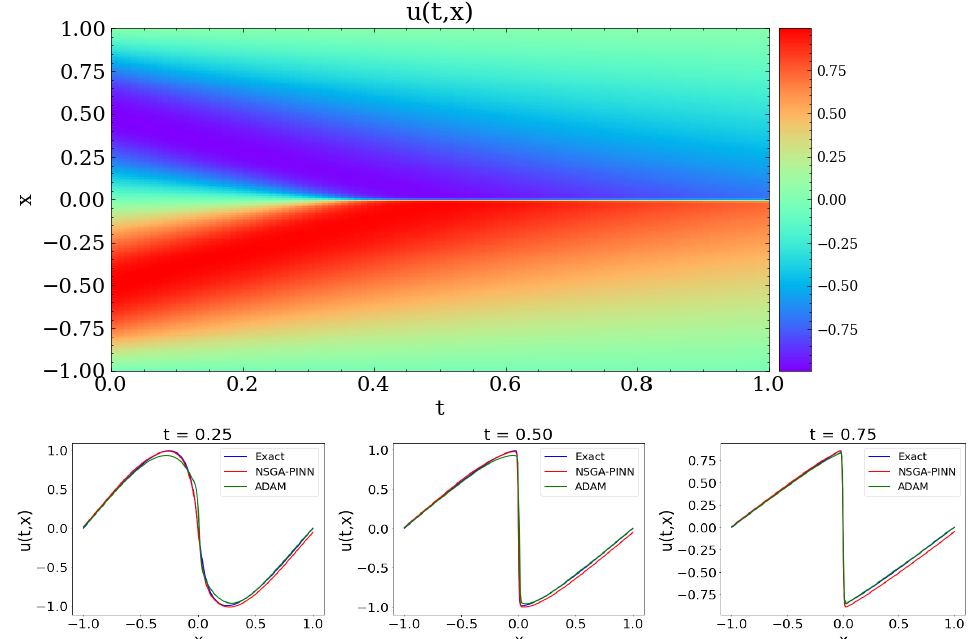
Figure 8. Burgers equation: the top panel shows the contour plots of the solution of the Burgers equation. The lower figure shows the comparison of the exact value with the predicted value at different time point.